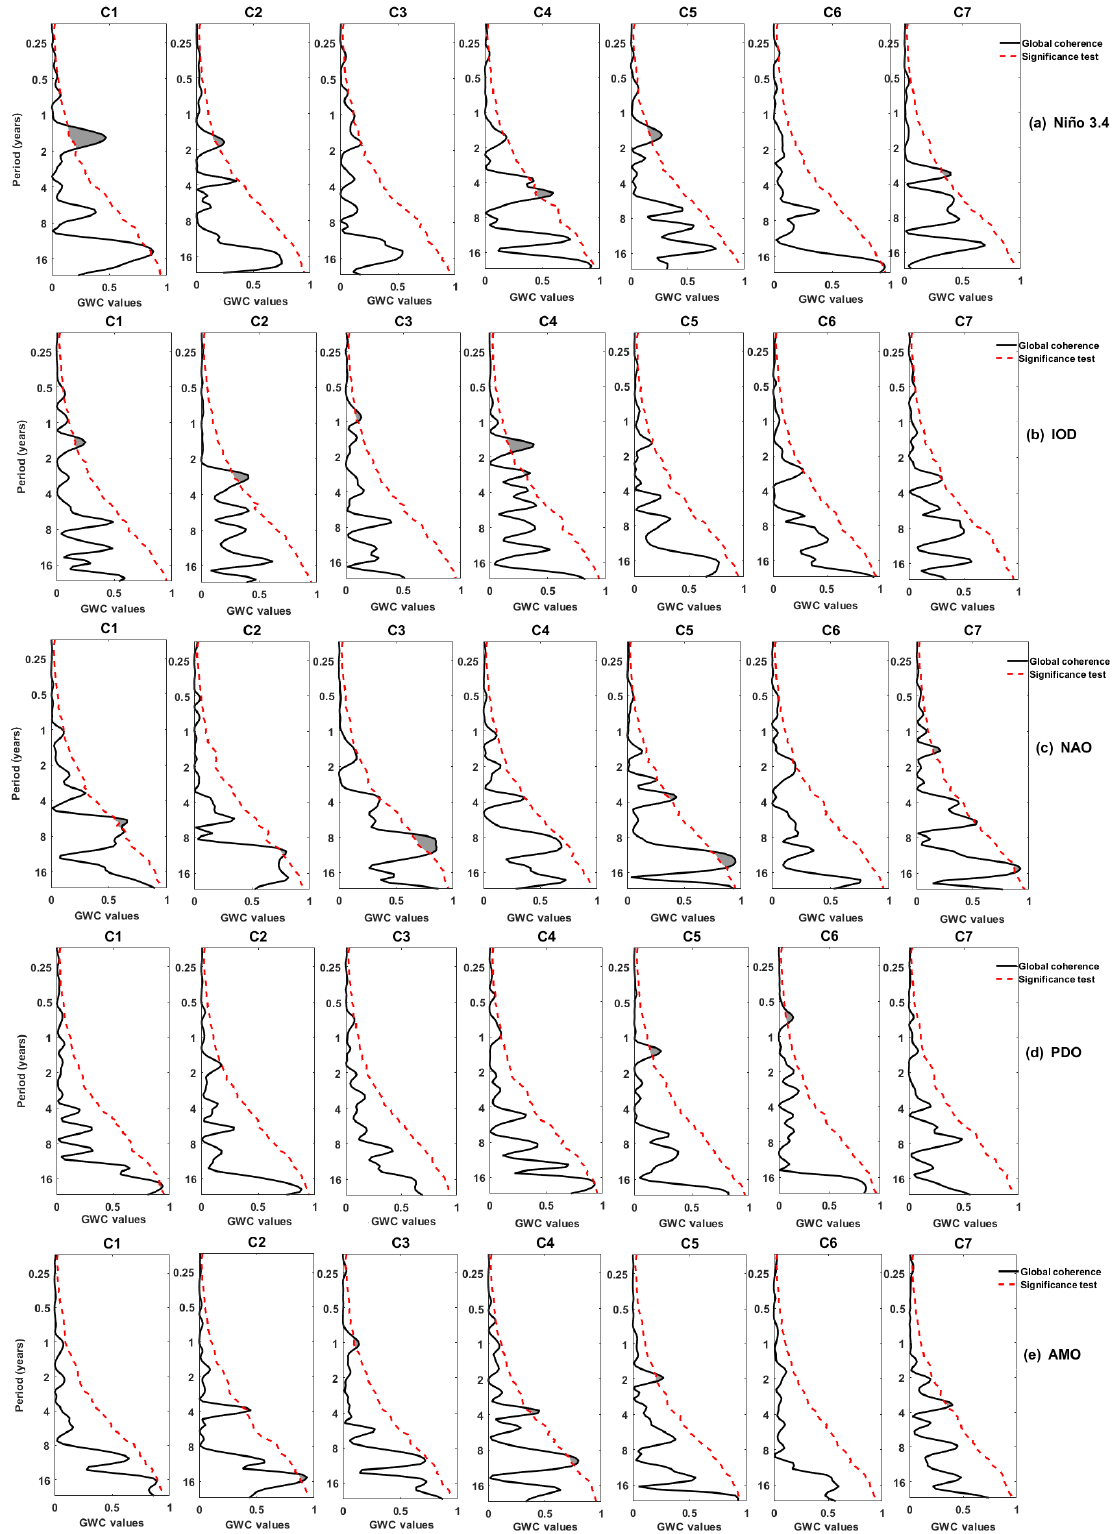
Figure 6. Global wavelet coherence (GWC) between precipitation and climate indices. Top to bottom: Niño 3.4, IOD, NAO, PDO, and AMO. From left to right: community 1 to community 7. WCA values are shown as solid lines, and significant connections (at the 95% significance level) are marked in